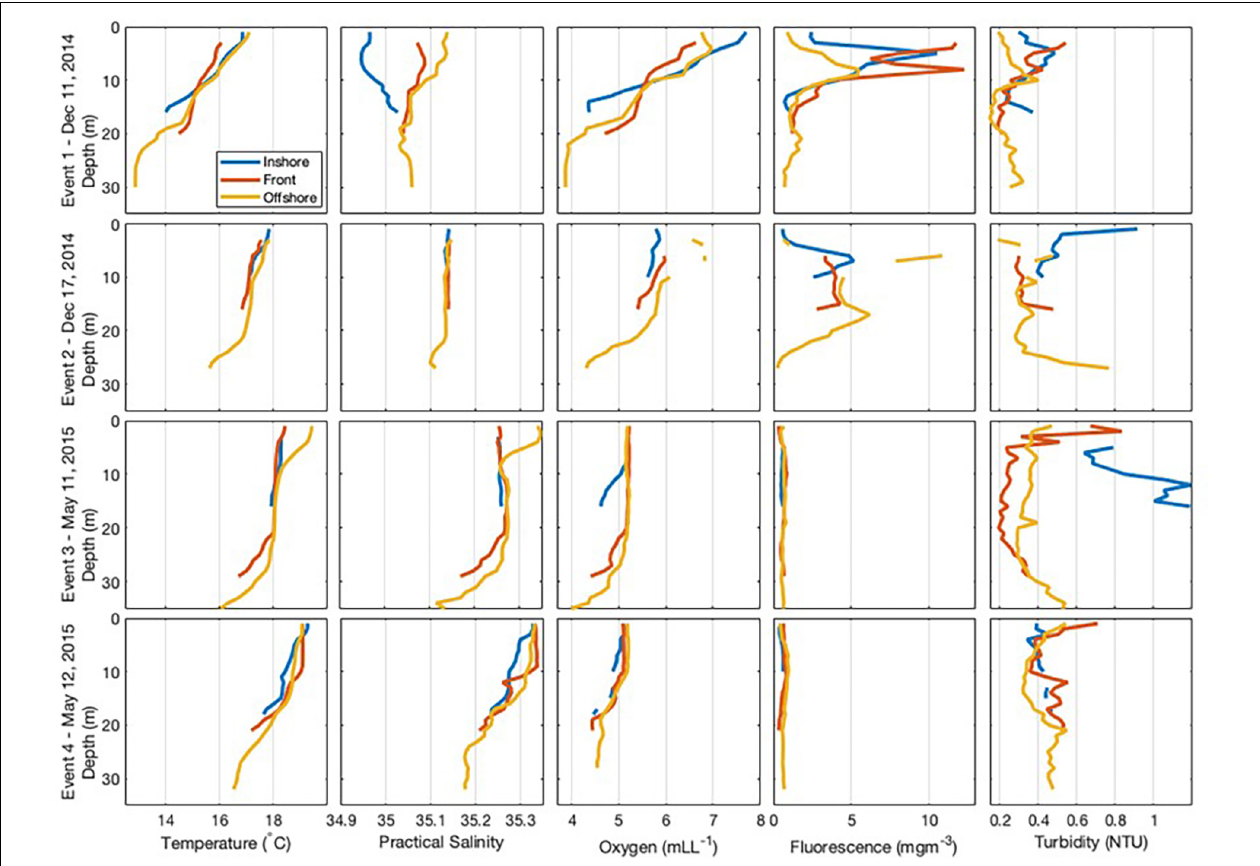
FIGURE 3 | Cross-shore transect for each frontal event showing vertical sections of temperature, salinity, oxygen, fluorescence, and turbidity recorded at each zone within the coastal nearshore of Sardinia Bay region during December 2014–May